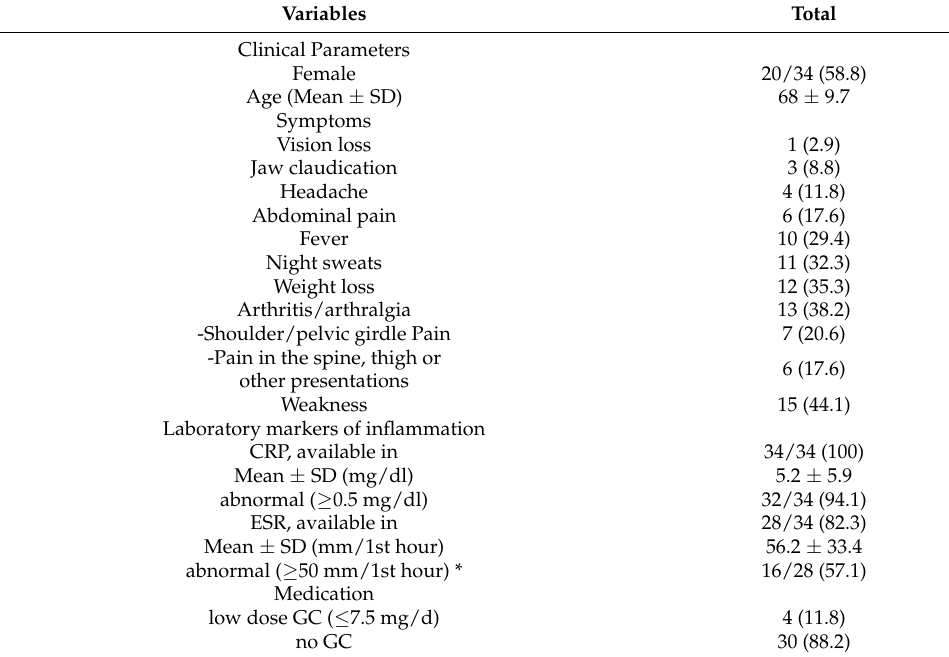
Figure 2. A 58-year-old woman with typical symptoms of polymyalgia rheumatica, including shoulder and hip girdle pain. Maximum intensity projection ( middle ) revealed intense uptake in multiple joints and in the thoracic aorta. Transaxial CT, PET and PET/CT revealed intense uptake in the AC joints ( left ) and aorta ascendens ( right ), suggestive for combined polymyalgia rheumatica and giant cell arteritis. Table 1. Patients’ characteristics at time of